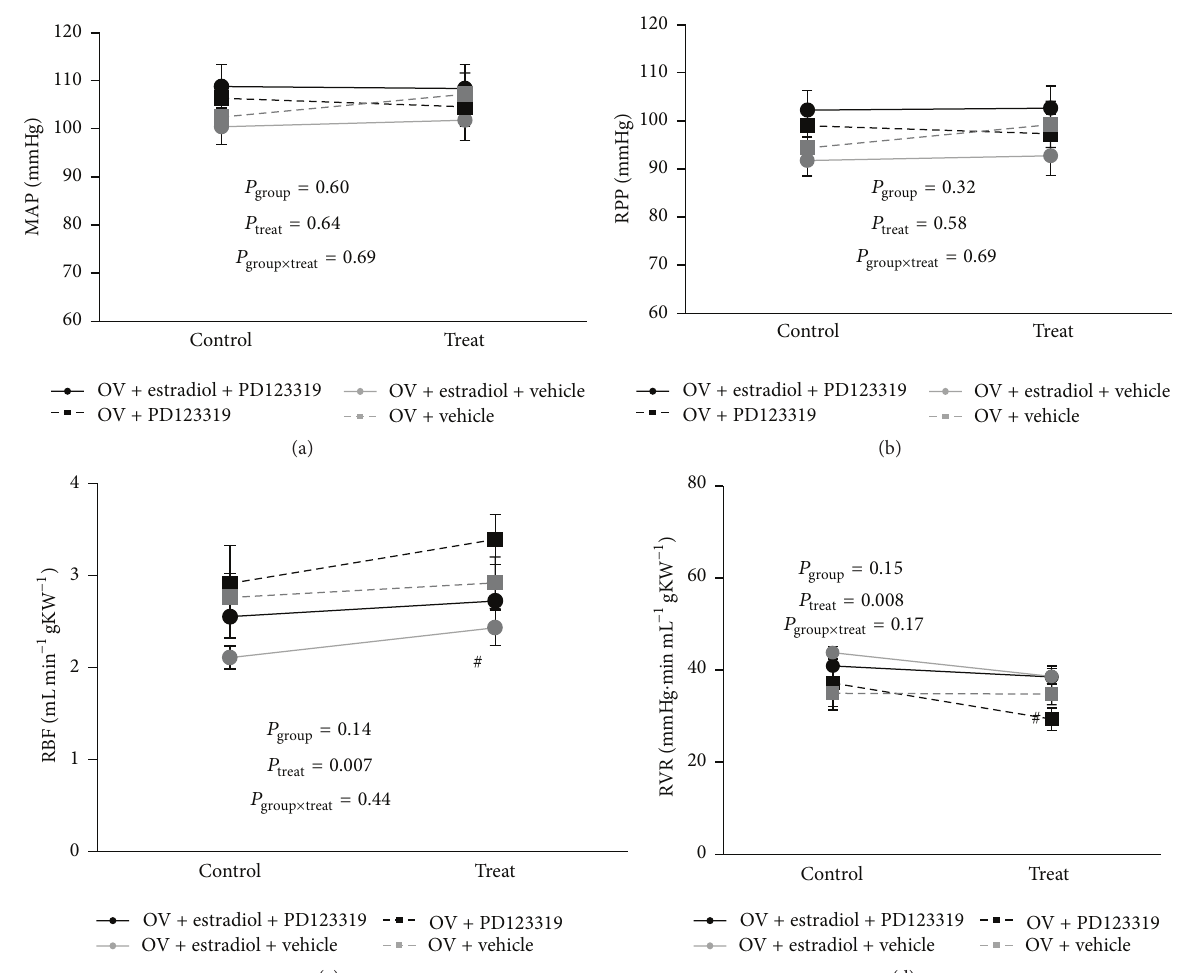
Figure 1: Hemodynamic variables before and after administration of vehicle or PD123319. Data are presented as mean ± SEM. The 𝑃 values were derived from repeated measures ANOVA with factor groups, treatment, and their interaction. 𝑛 = 5 per group. MAP, mean arterial pressure; RPP, renal perfusion pressure; RBF, renal blood flow per gram kidney weight; RVR, renal vascular resistance; OV, ovariectomized group.